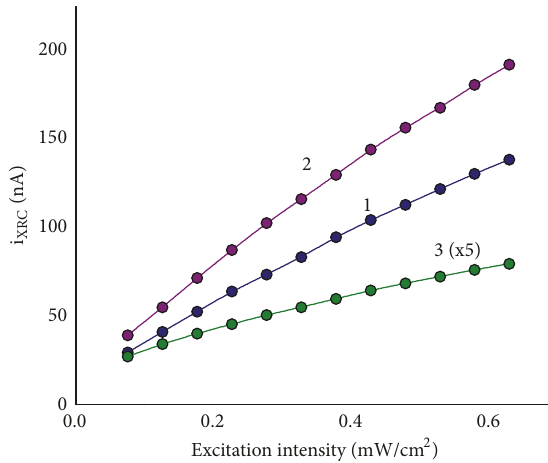
Figure 4: Lux-ampere characteristics of XRC of the ZnSe sample at various temperatures: 8 K (1) , 85 K (2) , and 295 K (3) (the intensity of the field in the sample equals 8 V/cm).